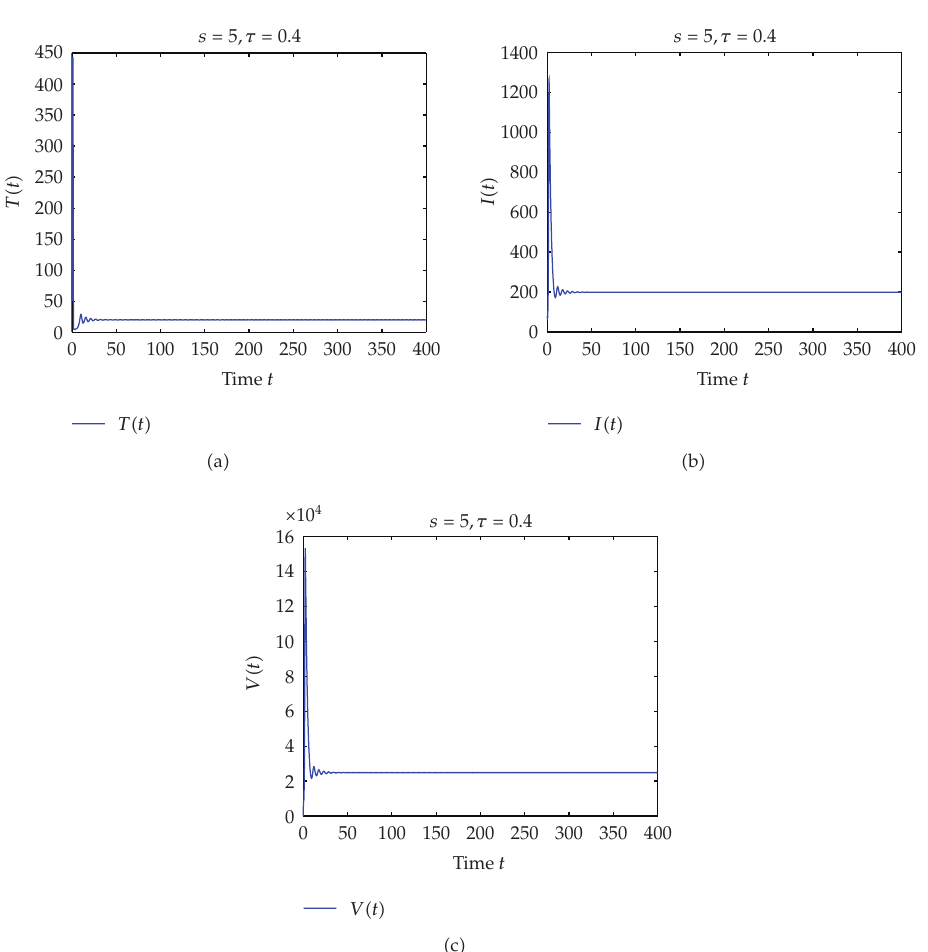
Figure 1: (cid:4) a (cid:5) - (cid:4) c (cid:5) show that uninfected cells, infected cells and virus converge to their equilibrium with parametric values as stated in the text with τ (cid:8) 0 . 4. They show that the equilibrium is asymptotically